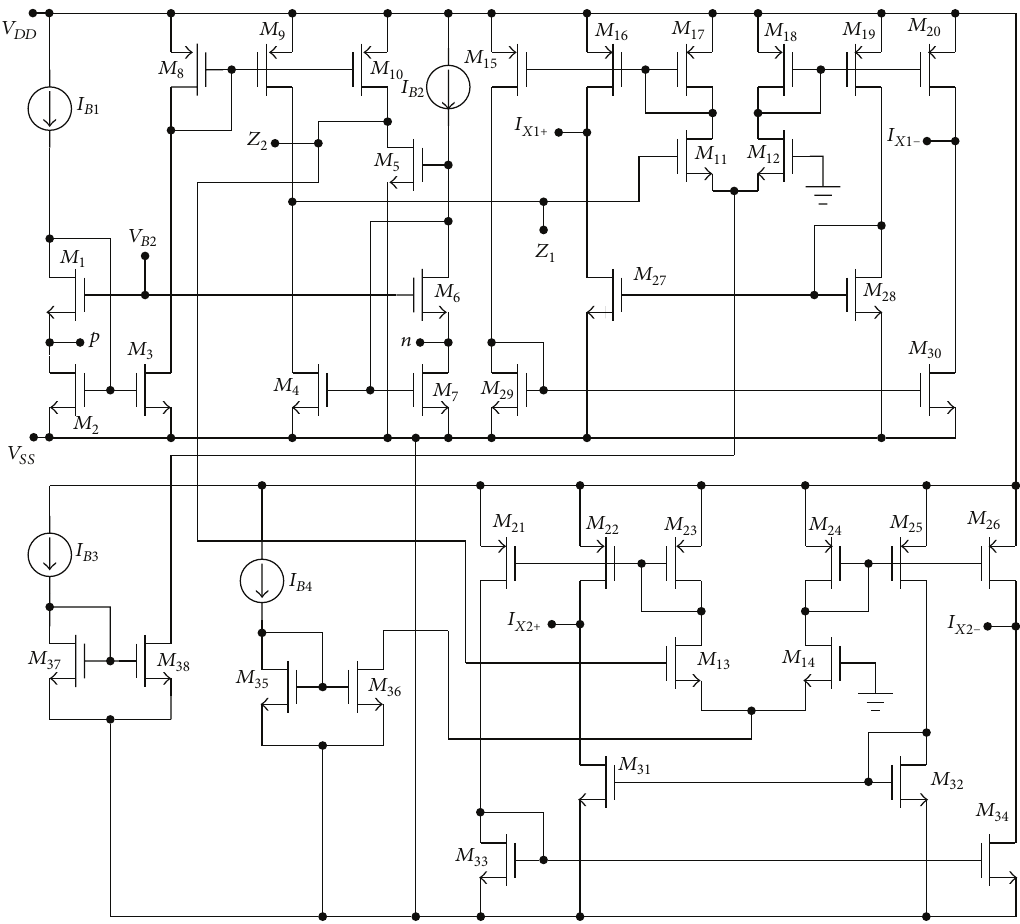
Figure 4: CMOS implementation of MO-CCCDTA